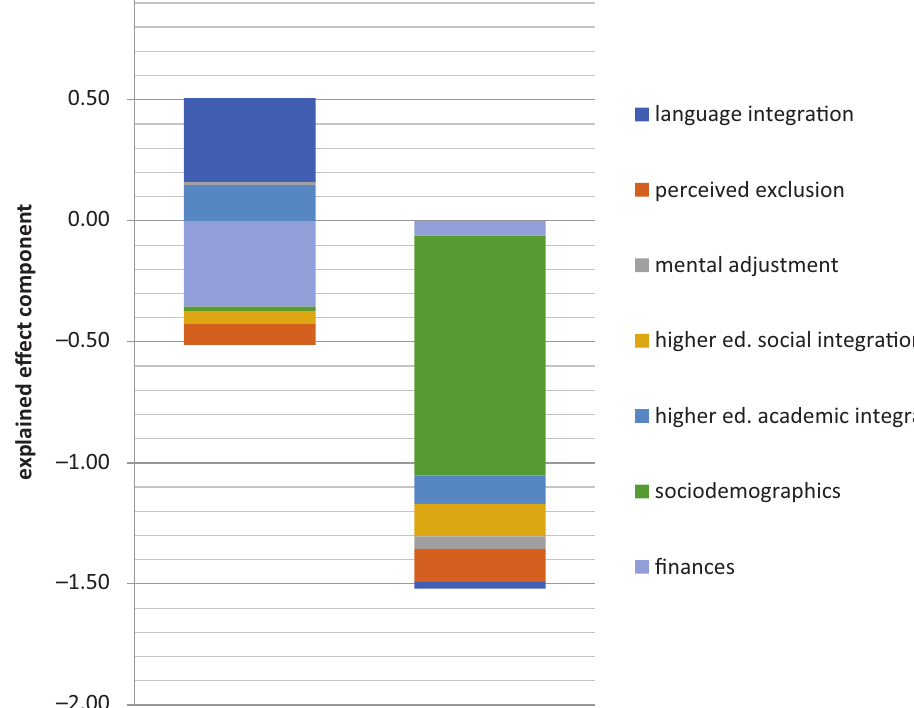
Figure 2. Decomposition of the migration channel effect conditional on the reference group (Fairlie decomposition). Source: Own calculation based on the study preparation survey (WeGe). Notes: Ratios of the effect of the migration channel explained by groups of variables (percent) using complete model M4 with all covariates; N = 954 with multiple imputed data; for more information on the specified models see Table 2 in the Supplementary File